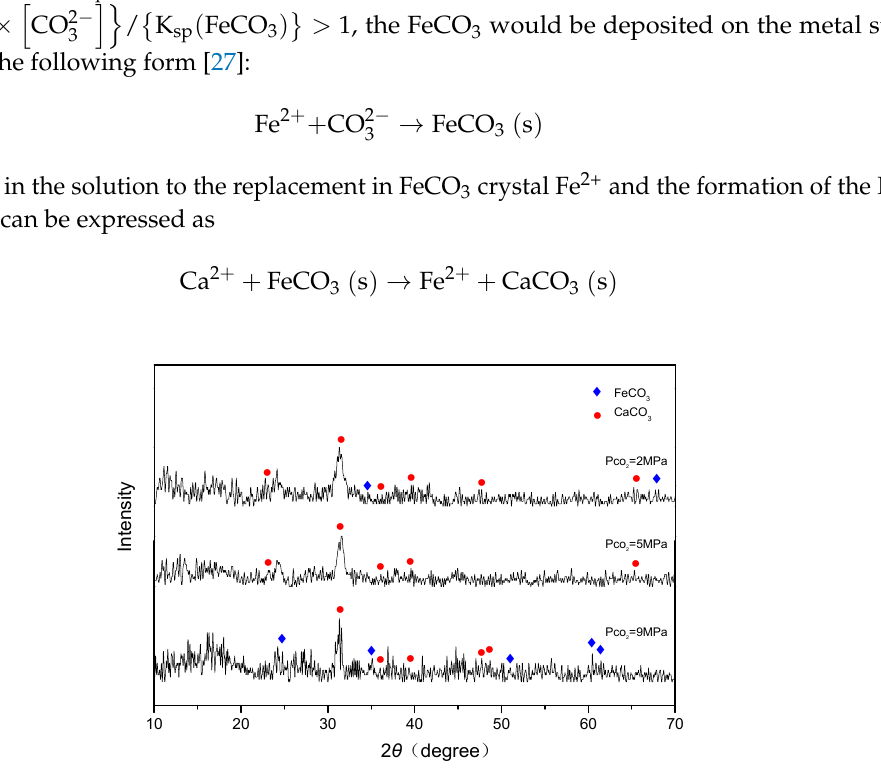
Figure 10. XRD spectra of surface layer on the corroded samples.